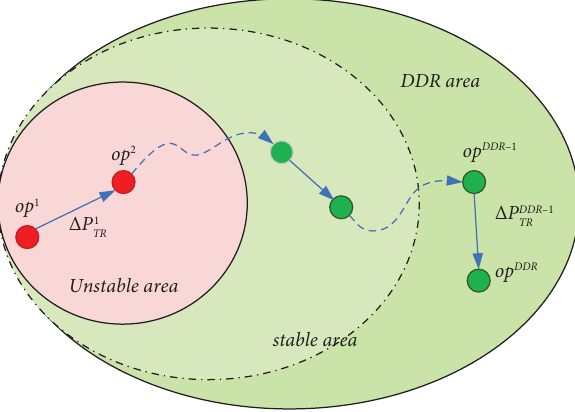
Figure 1: Picture of the proposed sequential